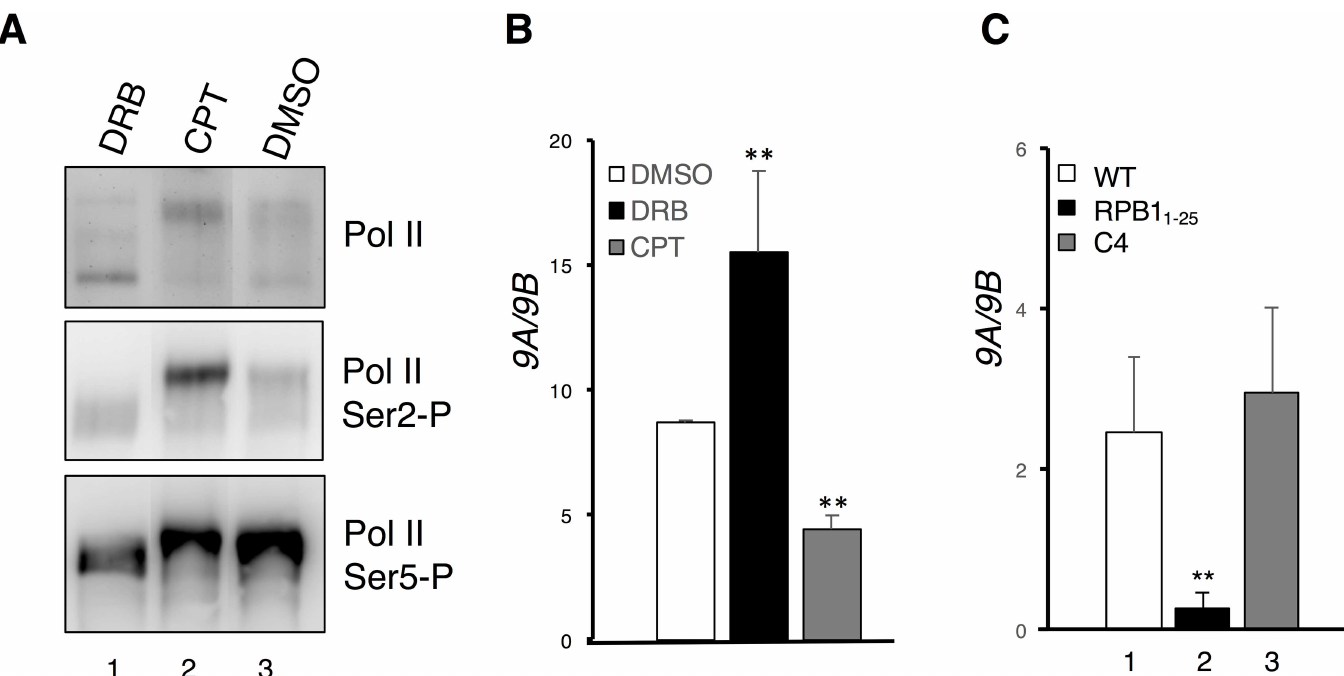
Fig 4. Pol II CTD phosphorylation and truncation impact on gTlr9 alternative splicing. ( A ) CTD phosphorylation was examinedby Western immunoblotting using specific monoclonal antibodiesagainst different forms of Pol II. DRB, a p-TEFb inhibitor, blocks Ser2 phosphorylation (Ser2-P) and CPT promotes Ser2-P (Cf. lanes 1 and 2 vs. lane 3; top and middlepanels). No significant changes were observed on Ser5-P in both treatments (bottom panel). ( B ) 9A/9B ratio was calculated under drug treatments. DRB significantly elevates 9A / 9B ratio, whereas CPT decreases 9A / 9B ratio. ( C ) Impacts on the 9A / 9B ratio by Pol II variants. WT, Pol II containing a full-lengthRPB1; RPB1 1-25 , Pol II harboringa truncated form of RPB1 in which the 26–52 repeats at its CTD are deleted; C4, Pol II carrying an R749H alteration within RPB1. All three RPB1 clones harbor an additional α -aminitinresistant mutation (N792D) for